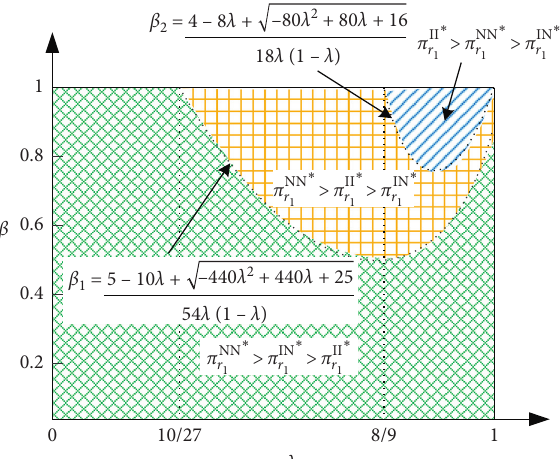
Figure 5: Comparison of R